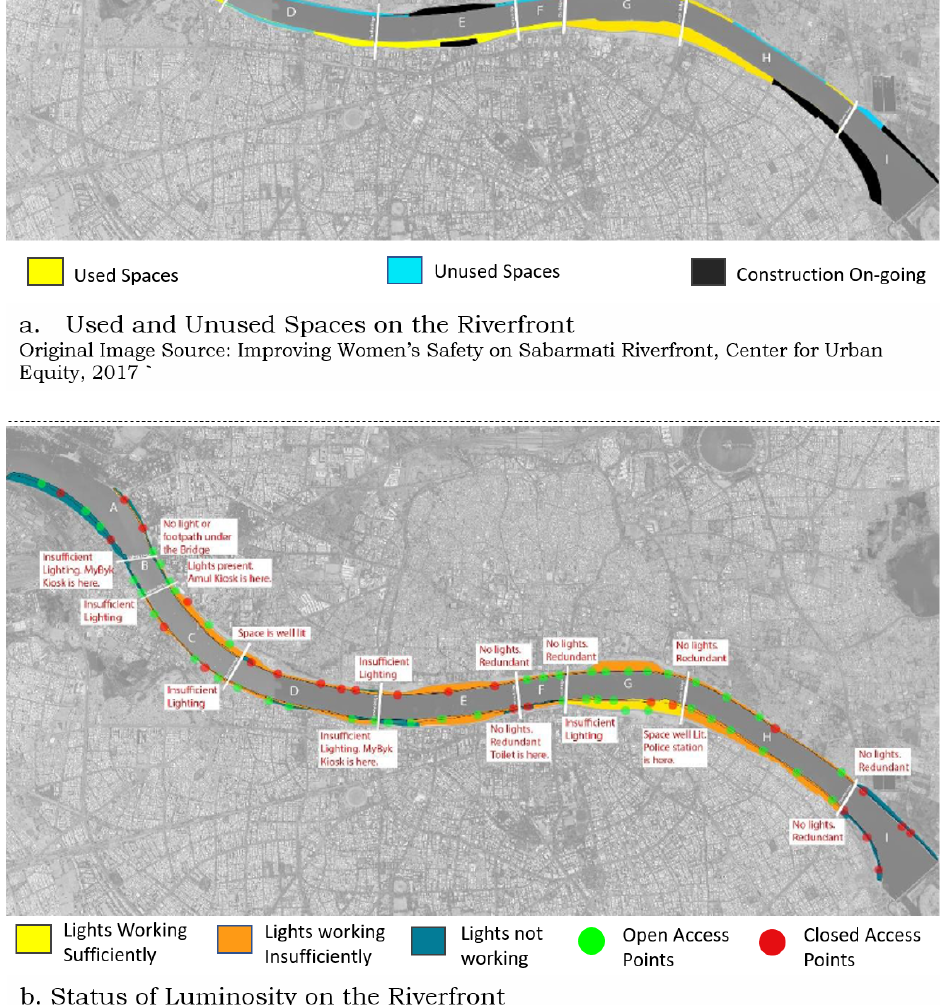
Figure 1. Status of infrastructure on the